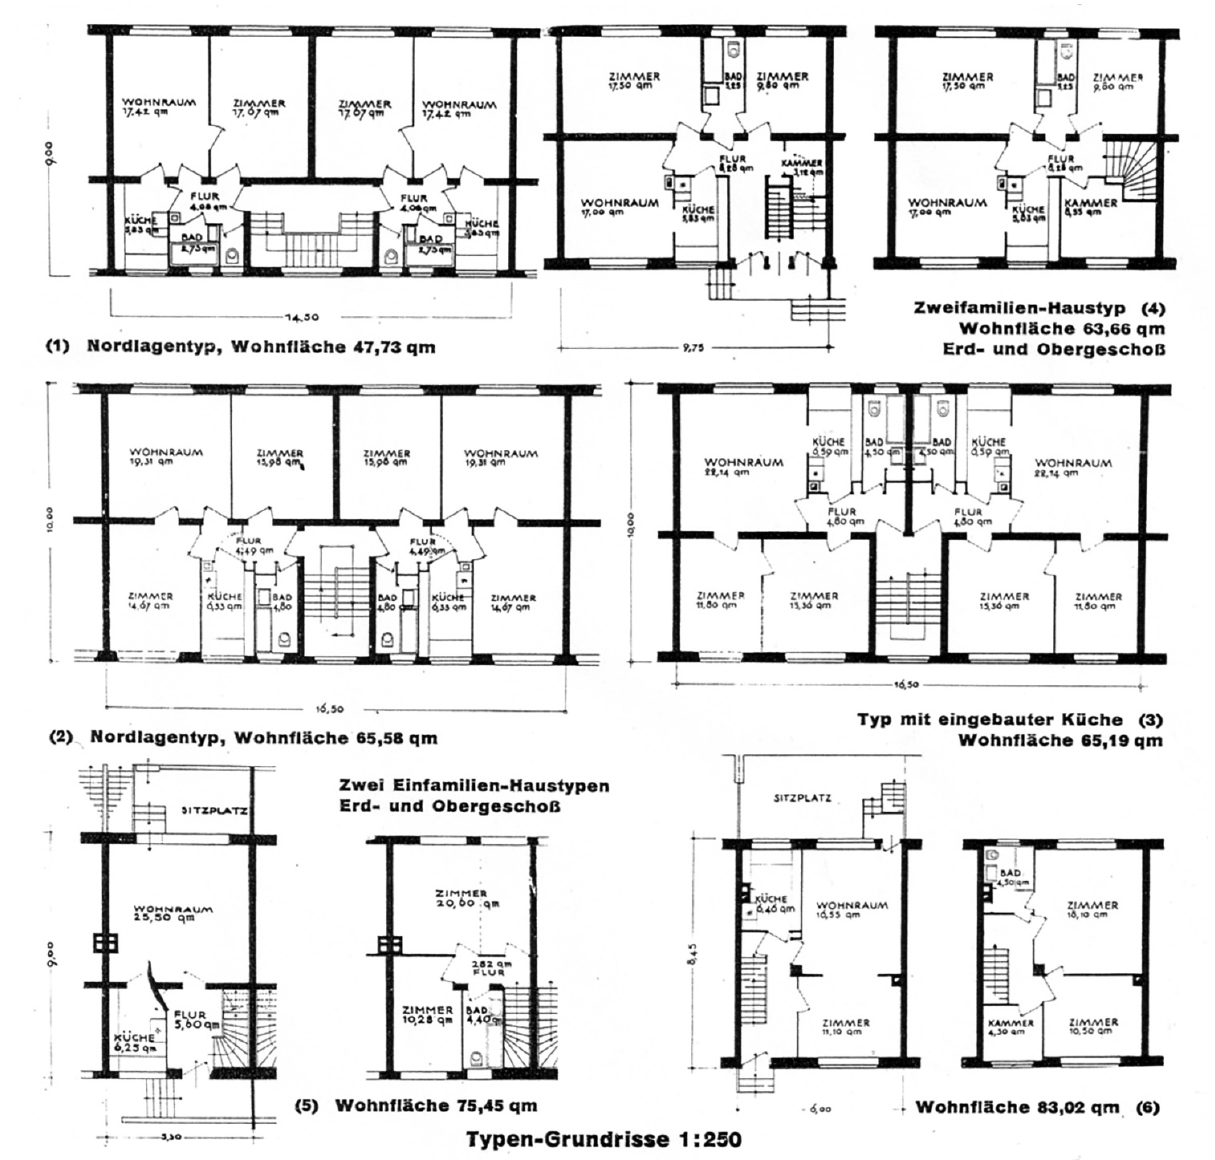
Figure 11. The Römerstadt Siedlung housing types. Source: Rudloff